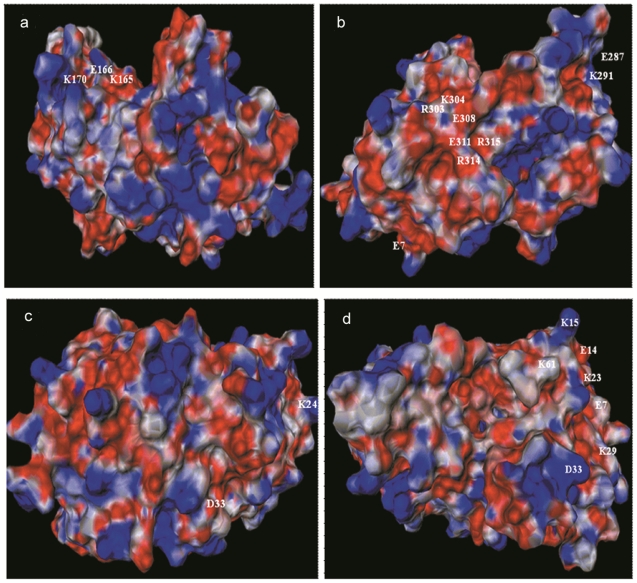
Electrostatic potential of CADH.Blue colour represents values more than 2 kcal/mol/e. Values between 0 to 2 kcal/mol/e is shown as blue gradient. Red colour represents values less than −2 kcal/mol/e. Red gradient shows electrostatic potential between −2 to 0 kcal/mol/e. The charged residues falling in the predicted epitopes are labelled. a) image centered on “auto”. b) Y rotation by 90° c) X rotation by 90° d) X+Y rotations by 90°.